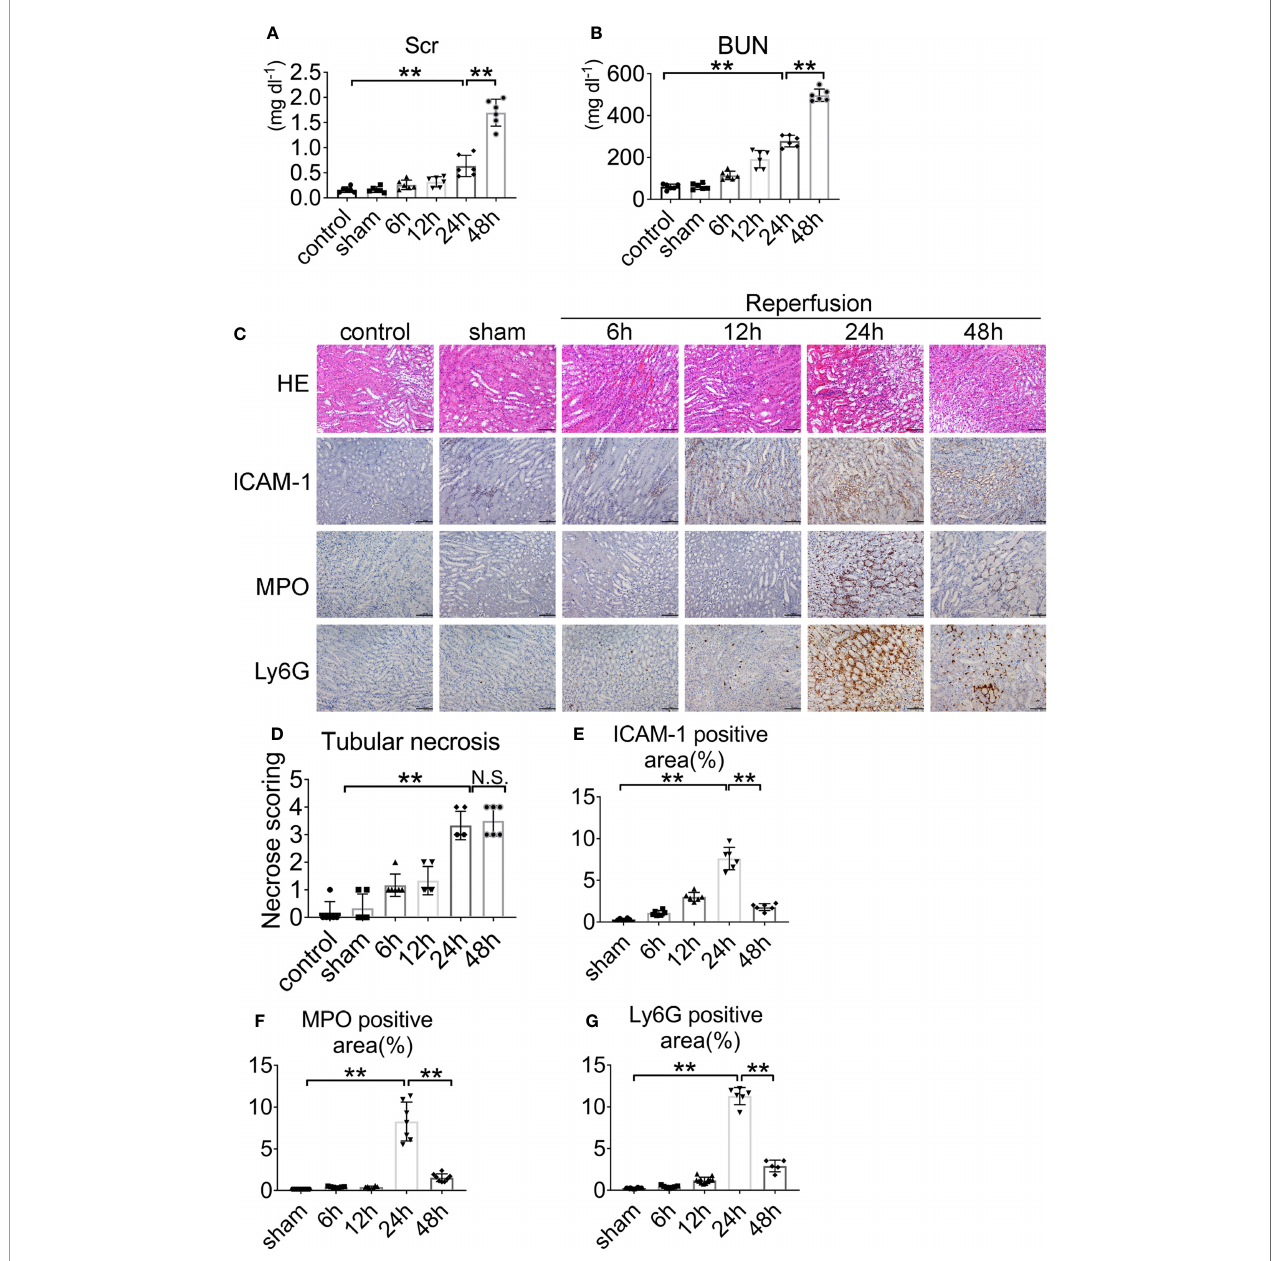
FIGURE 1 | Renal function and representative histology of kidney after renal IRI. (A) Serum creatinine (Scr) and (B) blood urea nitrogen (BUN) levels of WT mice with clamping time of the renal artery of 45 min and reperfusion for 6, 12, 24, 48 h or sham surgery, n = 5 – 6/group. (C) Histology of IRI kidney at different time points after reperfusion. HE staining (Row 1), ICAM-1 immunohistochemistry (Row 2), MPO immunohistochemistry (Row 3) and Ly6G immunohistochemistry (Row 4). Scale bar = 200 m M. The percentage of positive neutrophil staining in 10 non-overlapping fi elds was quanti fi ed using Image J software. (D) Score for histopathology of tubular damage after renal IRI using HE stained renal tissue sections. (E) ICAM-1-positive area. (F) MPO-positive area. (G) Ly6G-positive area. n = 5 – 6/group. **P < 0.01. N.S., No Signi fi cance. Data are presented as mean ±